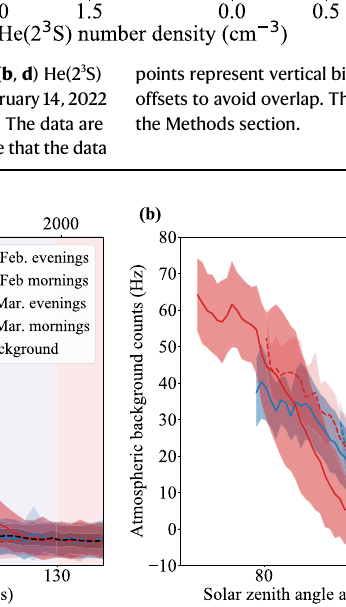
Fig. 3 | Passive He(2 3 S) measurement. a Atmospheric background counts as a functionofsolarzenithangle(SZA,bottomaxis)orshadowheight,i.e.,thelowest height of the atmosphere illuminated by sunlight (top axis). Baseline background counts of 75 – 100Hz (calculated from data with SZA>125°) are subtracted inde- pendently from each night of measurements. Excess background is observed whenever the helium layer (below 1000km) is illuminated. A strong asymmetry between morning (blue lines) and evening (red lines) is apparent, as well as a signi fi cantdecreasebetweenthe fi rstandsecondperiodsofmeasurements(solid